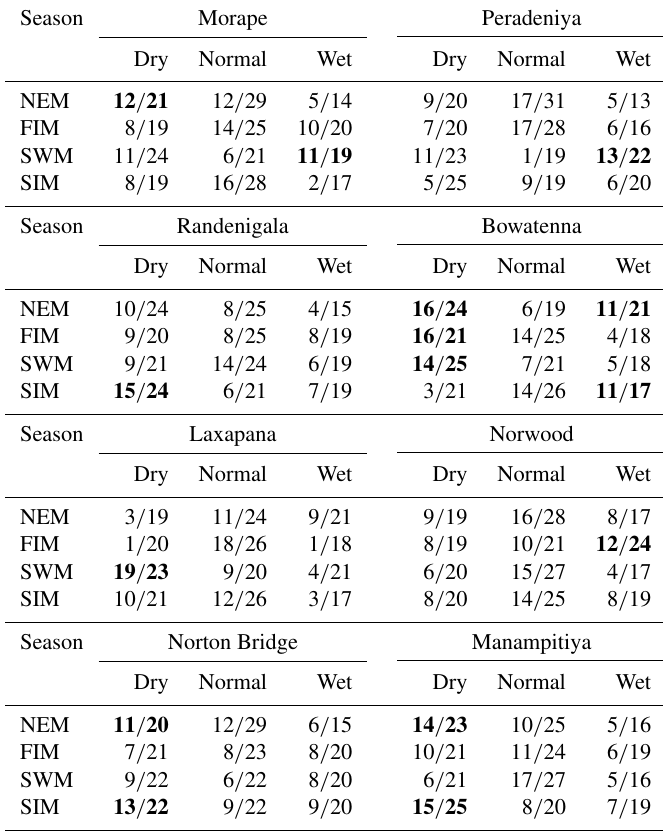
Table A5. Random forest model results. Highlighted cells indicate where there may be information content with respect to forecasting either dry or wet anomaly